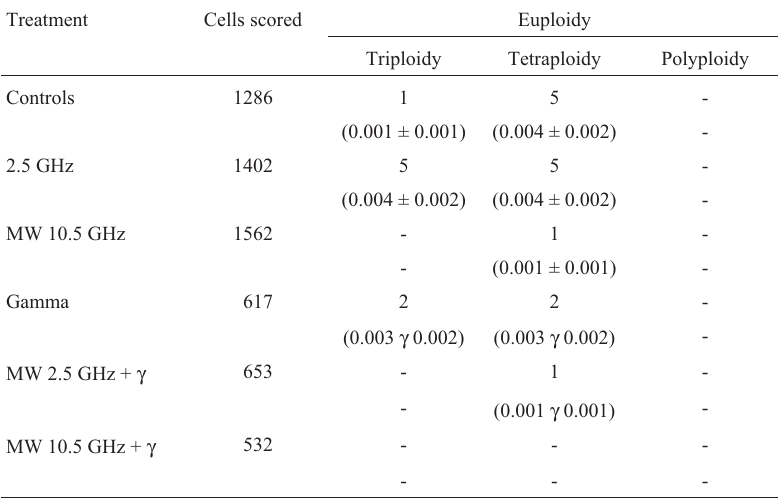
Table 5 - Number and frequencies of chromosomal aberrations in human lymphocytes according to the different treatments. Samples from the different subjects were pooled for each